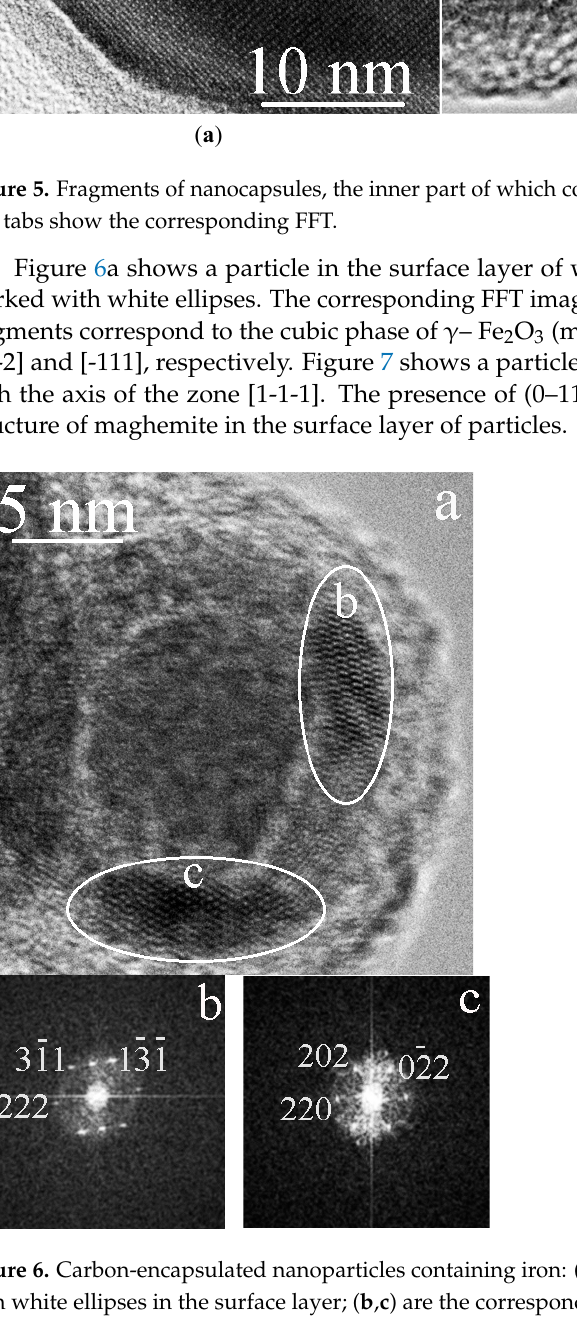
Figure 5. Fragments of nanocapsules, the inner part of which contains Fe 3 C carbide ( a ) and γ – Fe ( b ). The tabs show the corresponding FFT.